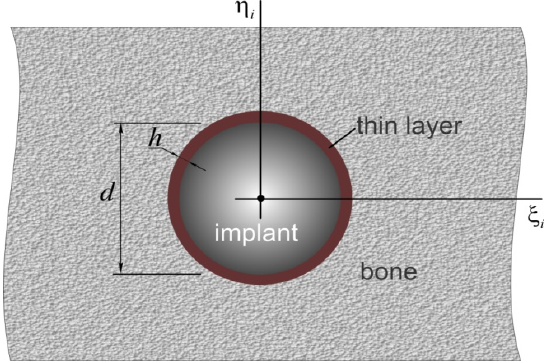
Figure 6. Scheme of the interaction of the implant with bone tissue: h is small layer thickness, d is the implant diameter